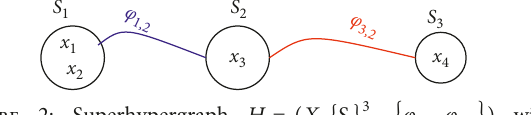
, φ , φ 􏼈 􏼉 3 􏽮 􏽯 ) with i i � 1 1 , 2 3 , 2